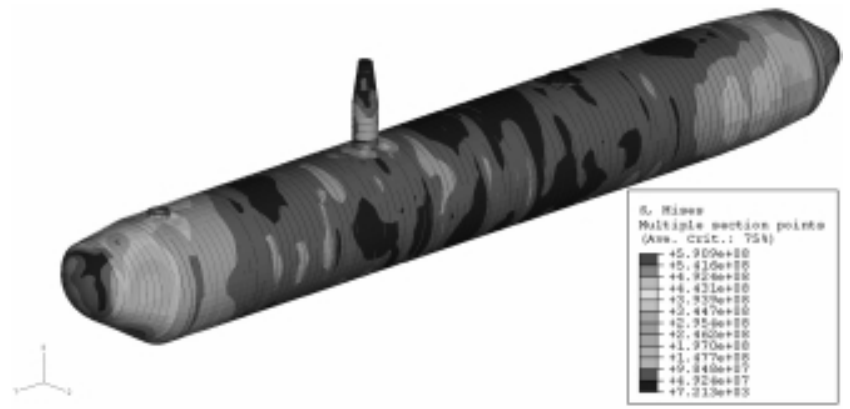
Fig. 10. Stress distribution at t = 0.01 sec.